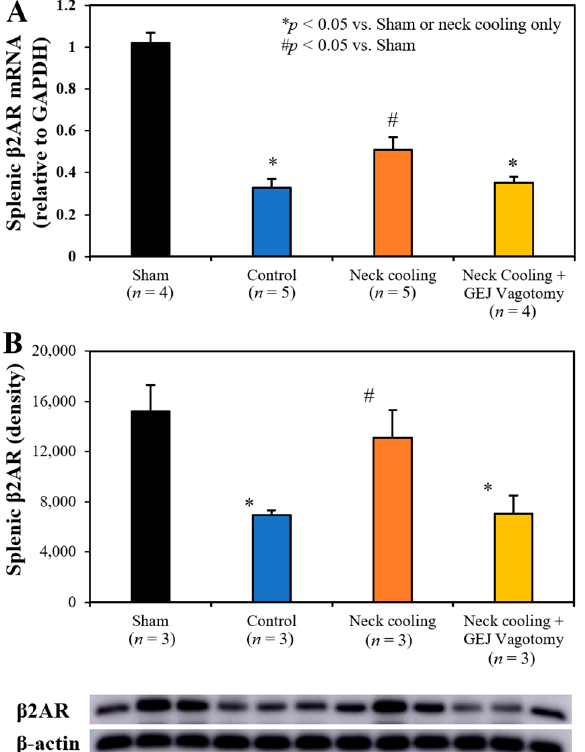
Figure 7. Splenic tissue expression of ( A ) β 2 -adrenergic receptor ( β 2AR) mRNA and ( B ) β 2AR pro- tein at 3 h after CLI.